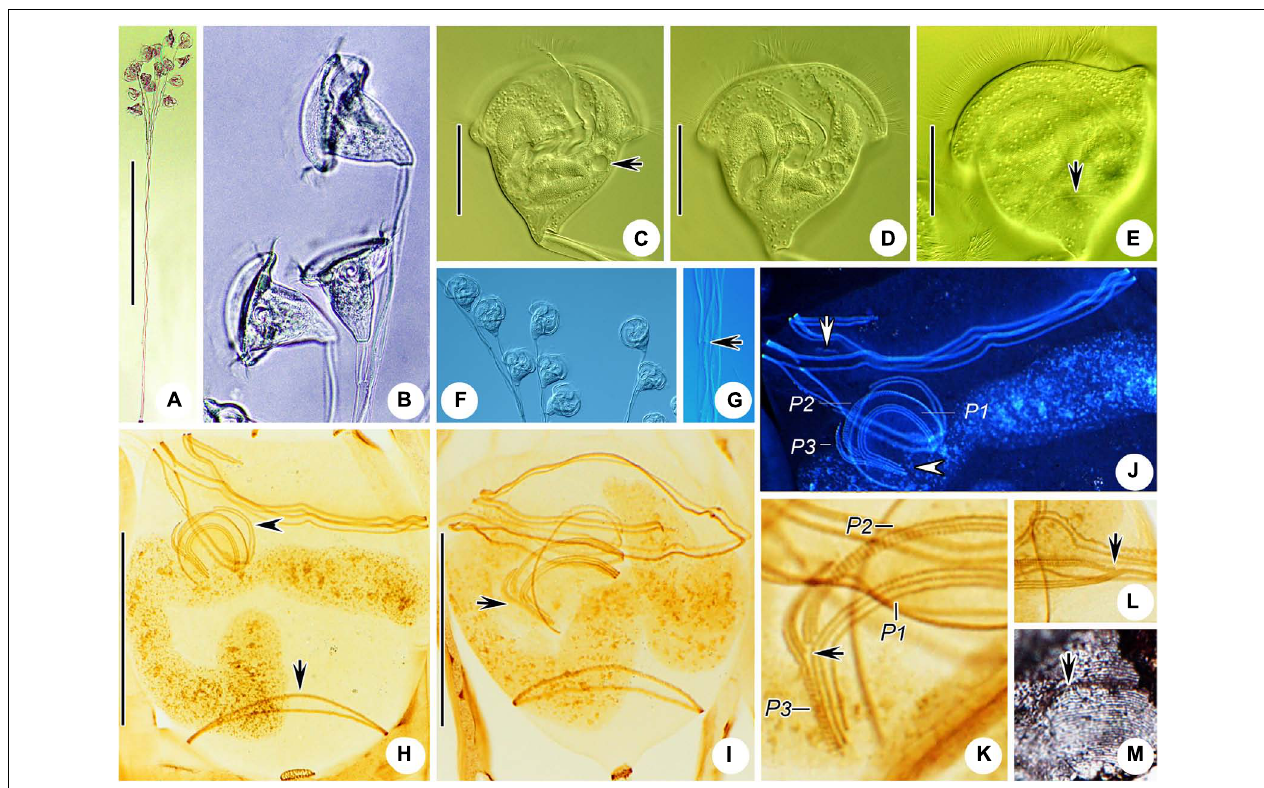
FIGURE 11 | Photomicrographs of Carchesium polypinum in vivo (A–G) , after protargol staining (H–L) , and after “dry” silver nitrate staining (M) . (A) A developing colony. (B–D,F) Different zooids showing the shape variation; arrow marks the contractile vacuole. (E) Pellicular striations; arrow marks the trochal band. (G) Detail of the stalk; arrow marks the discontinuous spasmoneme. (H,I) Two protargol-stained zooids showing the infraciliature; arrow in panel (H) marks the trochal band, arrowhead in panel (H) marks the germinal kinety, and arrow in panel (I) marks the infundibular polykinety 3. (J) Oral ciliature; arrow marks the epistomial membrane, and arrowhead marks the infundibular polykineties (image processed by the reverse function via Photoshop). (K) Infundibular polykineties 1–3 (P1–3); arrow marks the adstomal end of the inner row of P3. (L) Part of the oral ciliature; arrow marks the abstomal end of P2. (M) Silverline system; arrow marks the trochal band. Bars: 800 µ m in panel (A) , 30 µ m in panels (C–E) , and 30 µ m in panels (H,I)